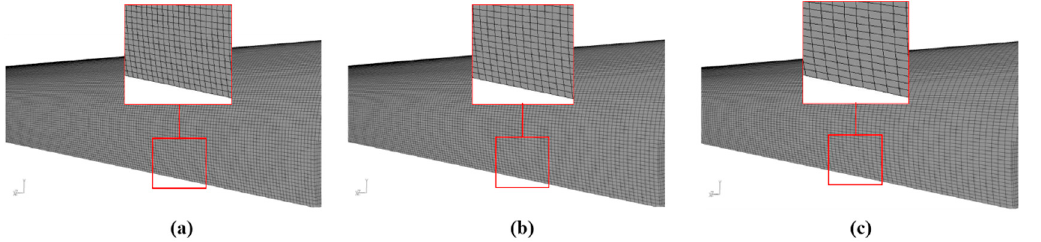
Figure 5. Grid sizes considered in the grid sensitivity analysis and details of the grid at the tunnel wall: ( a ) fine; ( b ) medium; and ( c ) coarse.